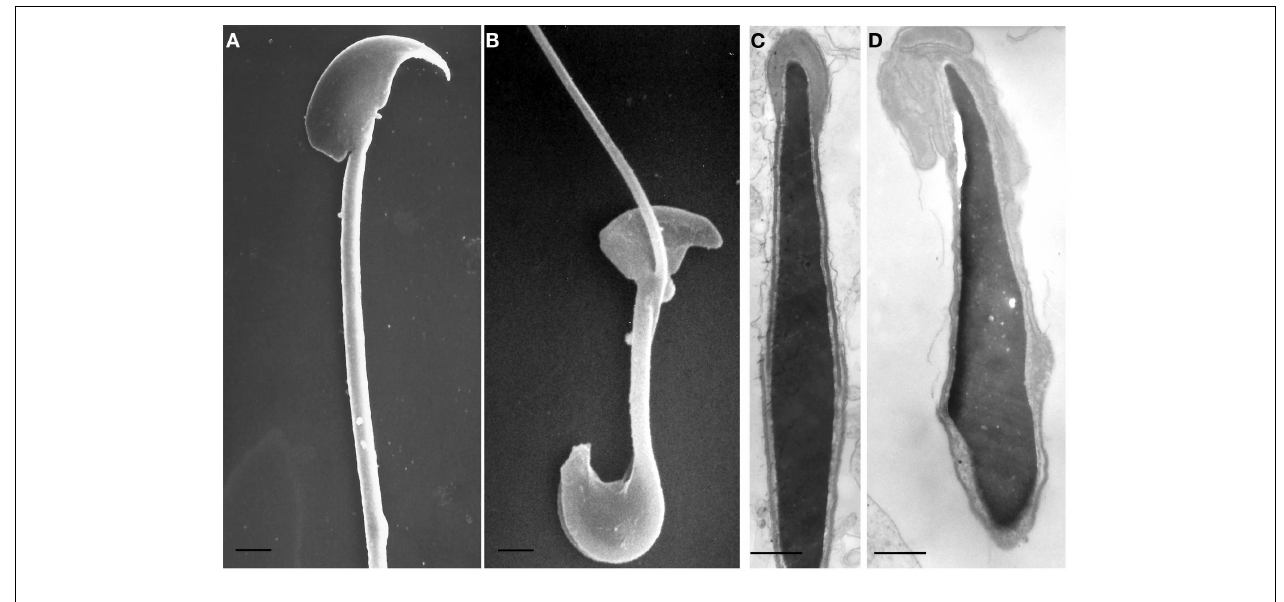
level, sperm from control mouse show a normal structure of both acrosome and nucleus, with a well condensed chromatin (C) . By contrast, the acrosome of theTwitcher sperm is aberrant and detached from the nucleus, the plasma membrane is also enlarged and redundant; the nuclear profile is irregular and the chromatin appears granular and uncondensed (D) . [ (A,B) : bars = 2 µ m; (C,D) : bars = 0,25 µ m]. Modified from Ref.